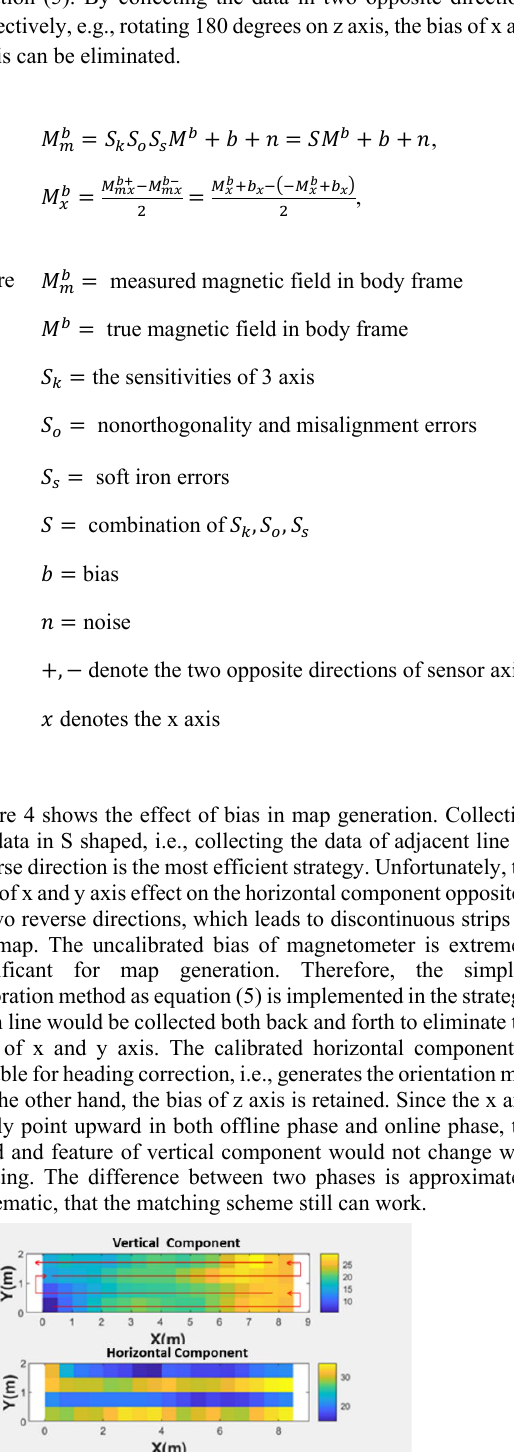
Figure 4. The illustration of collecting data by reverse direction